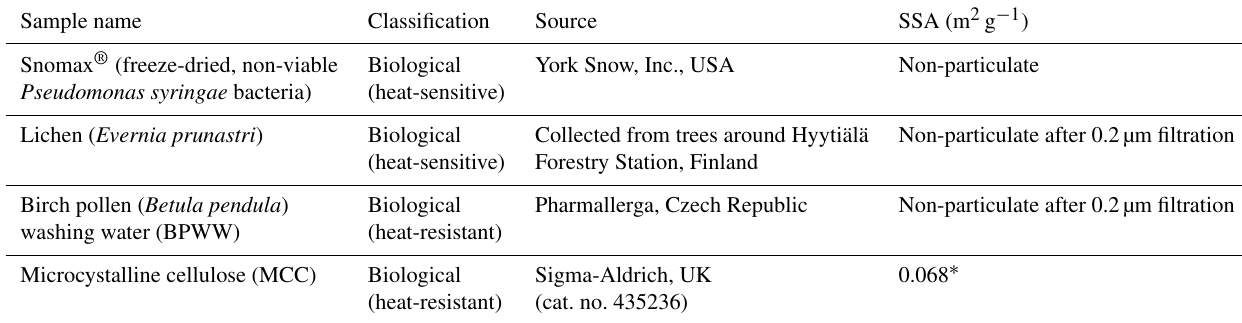
Table 3. Sample information for biological-based INP